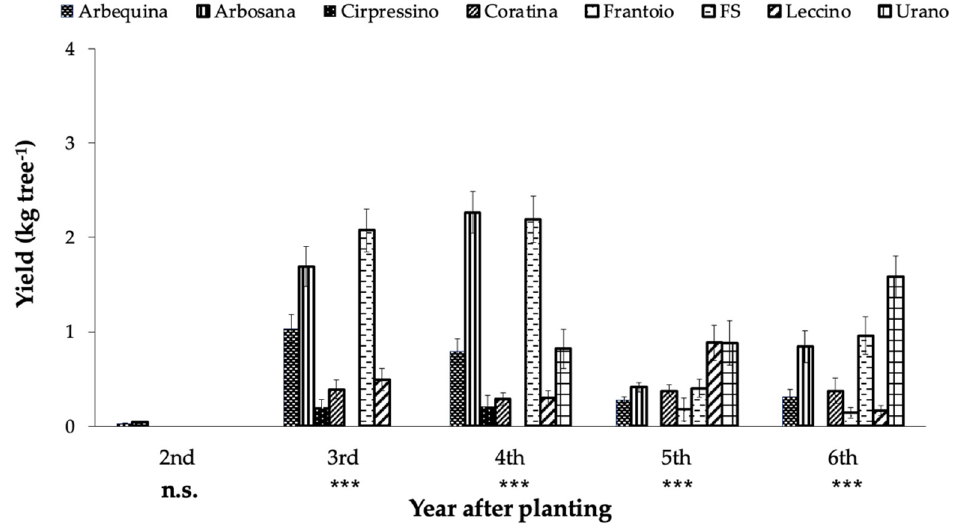
Figure 4. Effect of cultivar on yield (Y, kg tree − 1 ) for each experimental year. Standard error (SE) of the mean difference and least significant difference (LSD) ( p < 0.001) are reported. *** means p < 0.001. n.s. means no significance.